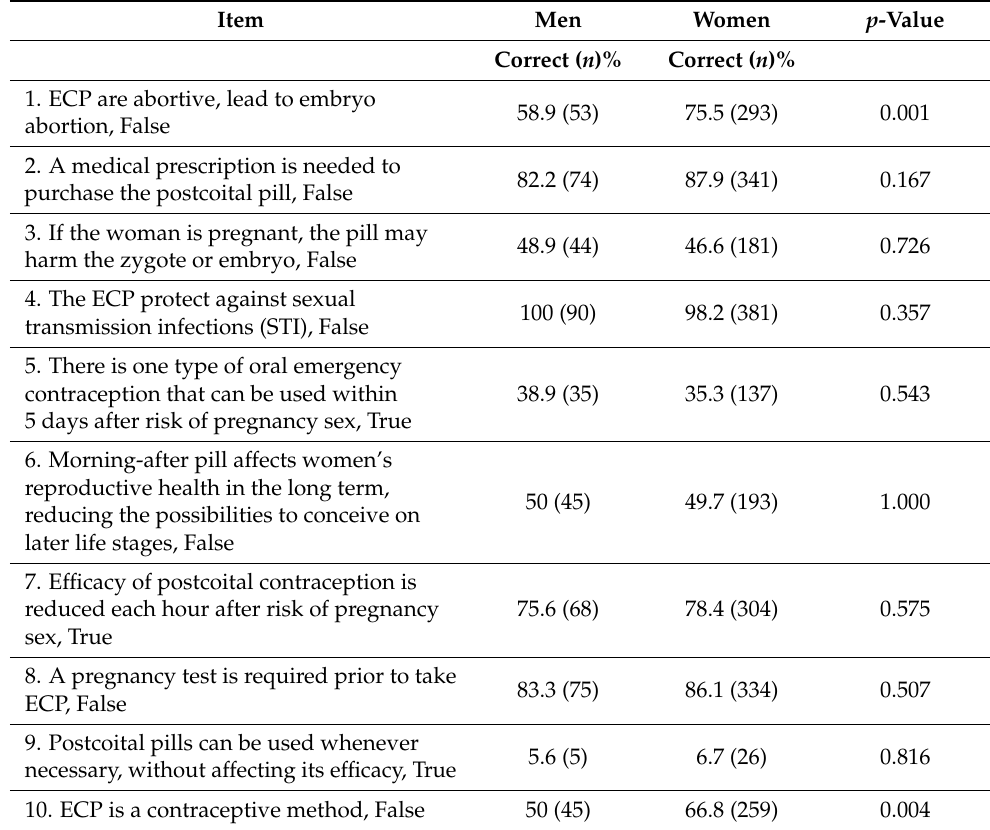
Table 2. Knowledge about ECP by